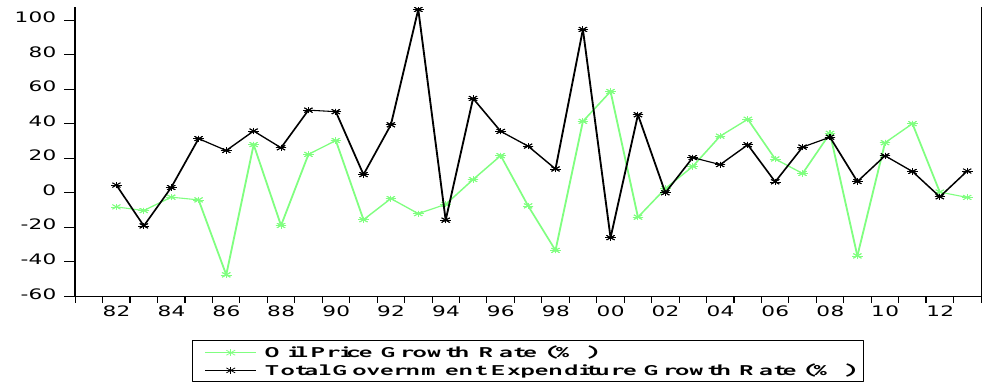
Figure 2 . Trend of oil price and government expenditure growth rate (1982-2013)